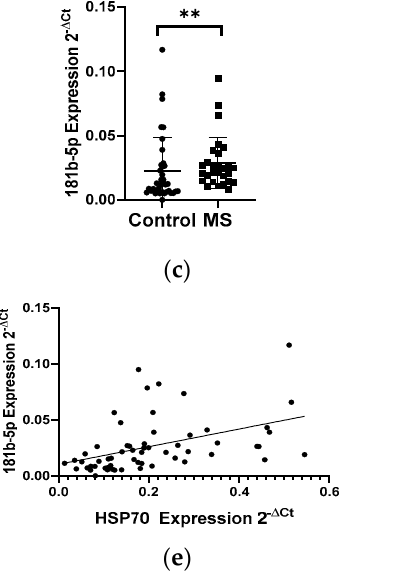
Figure 3. Expression levels and correlations of HSP27 and HSP70 and miR-18b1-5p in PBMCs from multiple sclerosis patients and healthy controls. Expression levels (2 - Δ Ct ) are shown for: ( a ) HSP27; ( b ) HSP70, and ( c ) miR-181b-5p, and ( d ) the expression level of miR-181-5p in PBMCs of MS patients according to type: RRMS ( n = 13) and SPMS ( N = 15). ( e ) Spearman correlation (R) plots for the expression levels of HSP70 with miR-181b (combined for all cohorts; N = 60). The PBMCs were from multiple sclerosis patients ( N = 28), aged 59 ± 5.5 years, and healthy controls, aged 60 ± 6 years ( N = 33). Expression levels were determined by real-time PCR (see Methods). Statistical analysis of differences between the groups of data was carried out using the Mann–Whitney U-test. Values of p ≤ 0.05 were regarded as statistically significant ( p * ≤ 0.05, p ** ≤ 0.01, and p **** ≤ 0.0001).